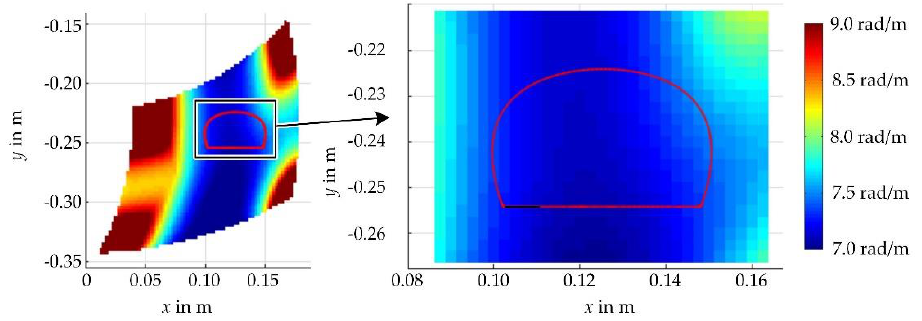
λ 2 over the workspace of the